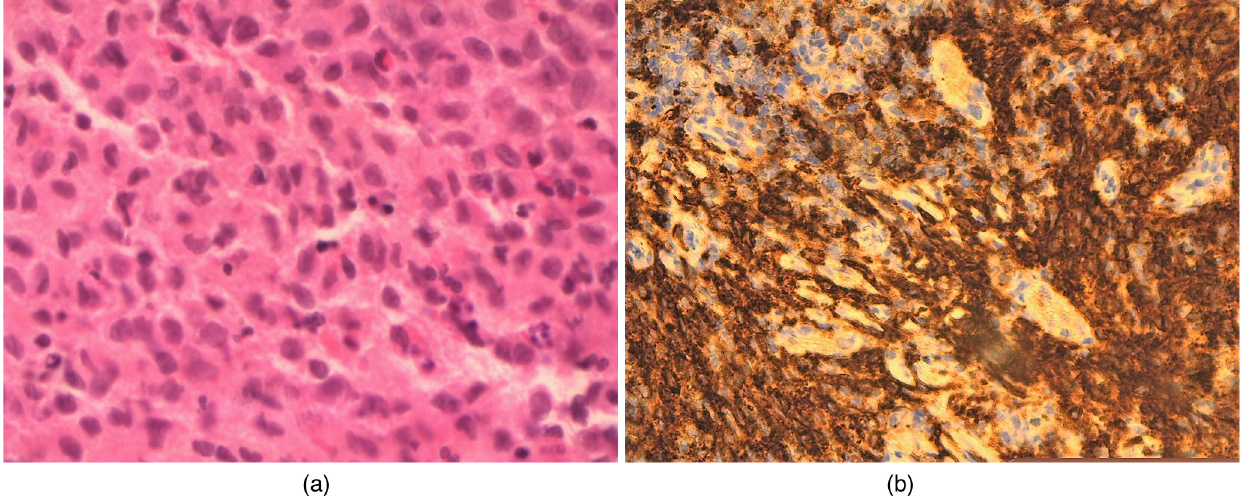
Fig. 3. Gingival and bone biopsies examination show Langerhans cells with eosinophil cytoplasm and reniform nuclei. (a) HES stain, original (cid:1) 200, (b) anti-CD1a IHC, original (cid:1) 200.